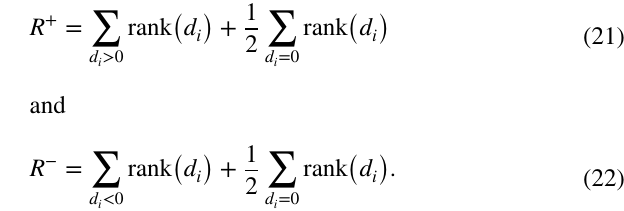
algorithm outperformed the first, and R for the opposite, then